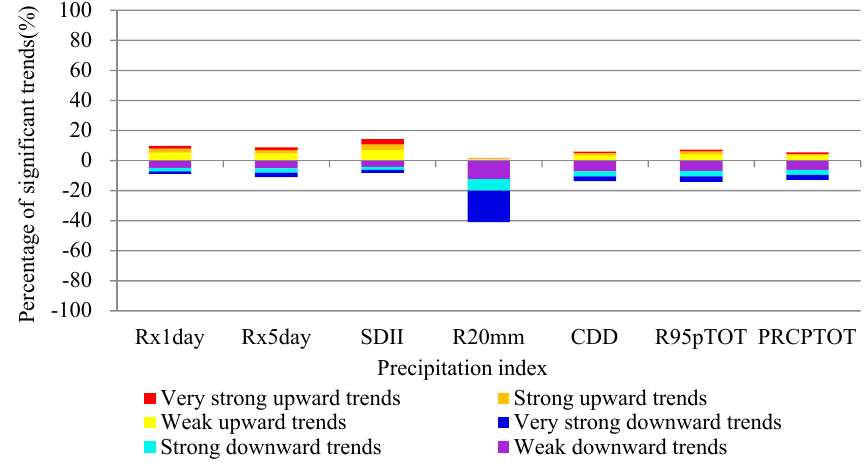
Figure 3. Percentages of trend (PCT) with di ff erent significant levels for each extreme precipitation index in the study area during the growth period of October 1961 to May